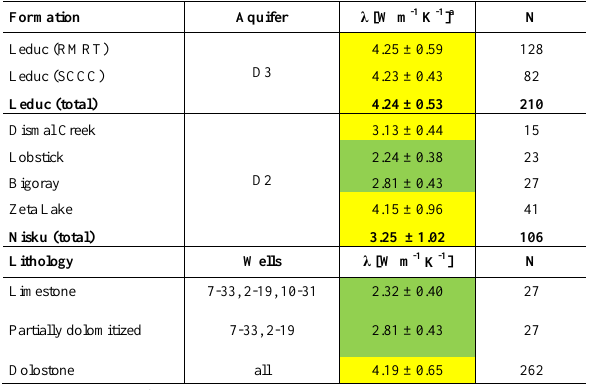
Table 3. Average thermal conductivity values of the analyzed reser- voir core samples. Table 3: Average thermal conductivity values of the anlyzed reservoir core samples